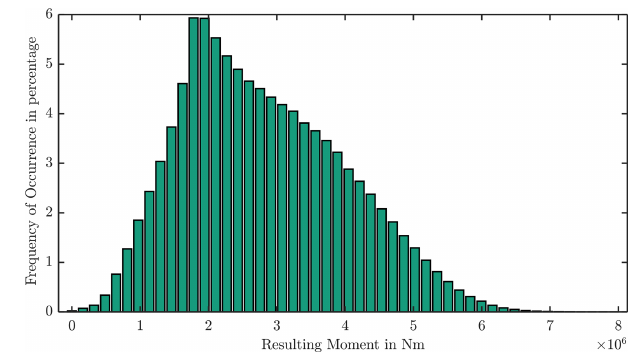
Figure 5. Classification of the resulting